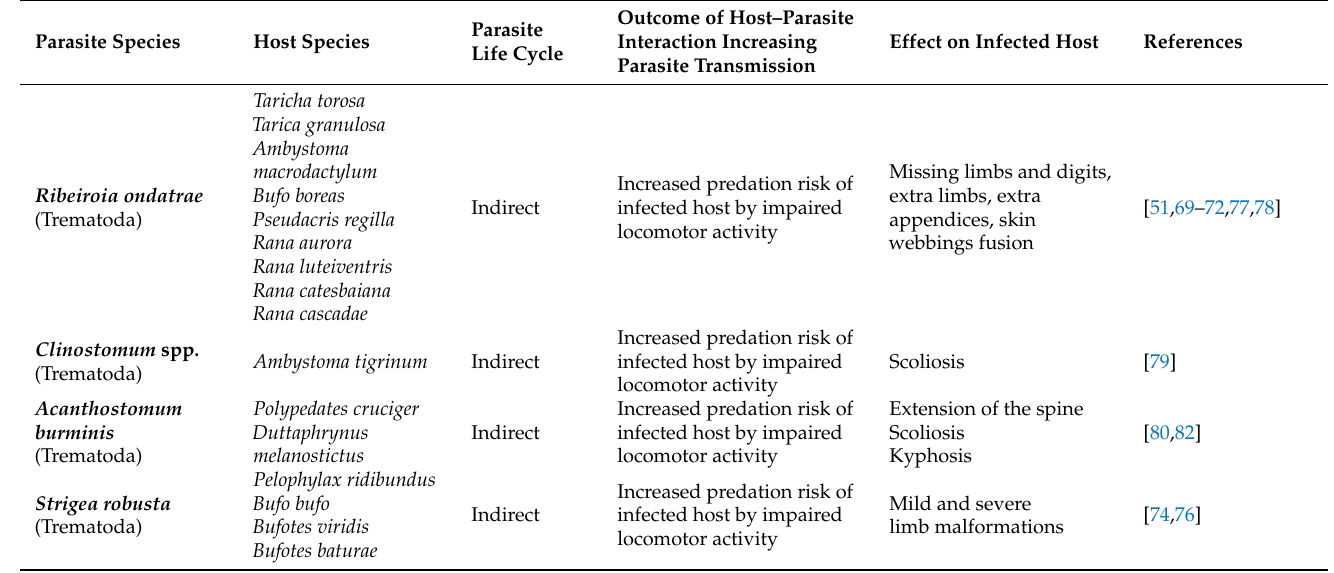
Table 2. Summary of studies reporting morphological manipulations in several amphibian hosts induced by parasites from different